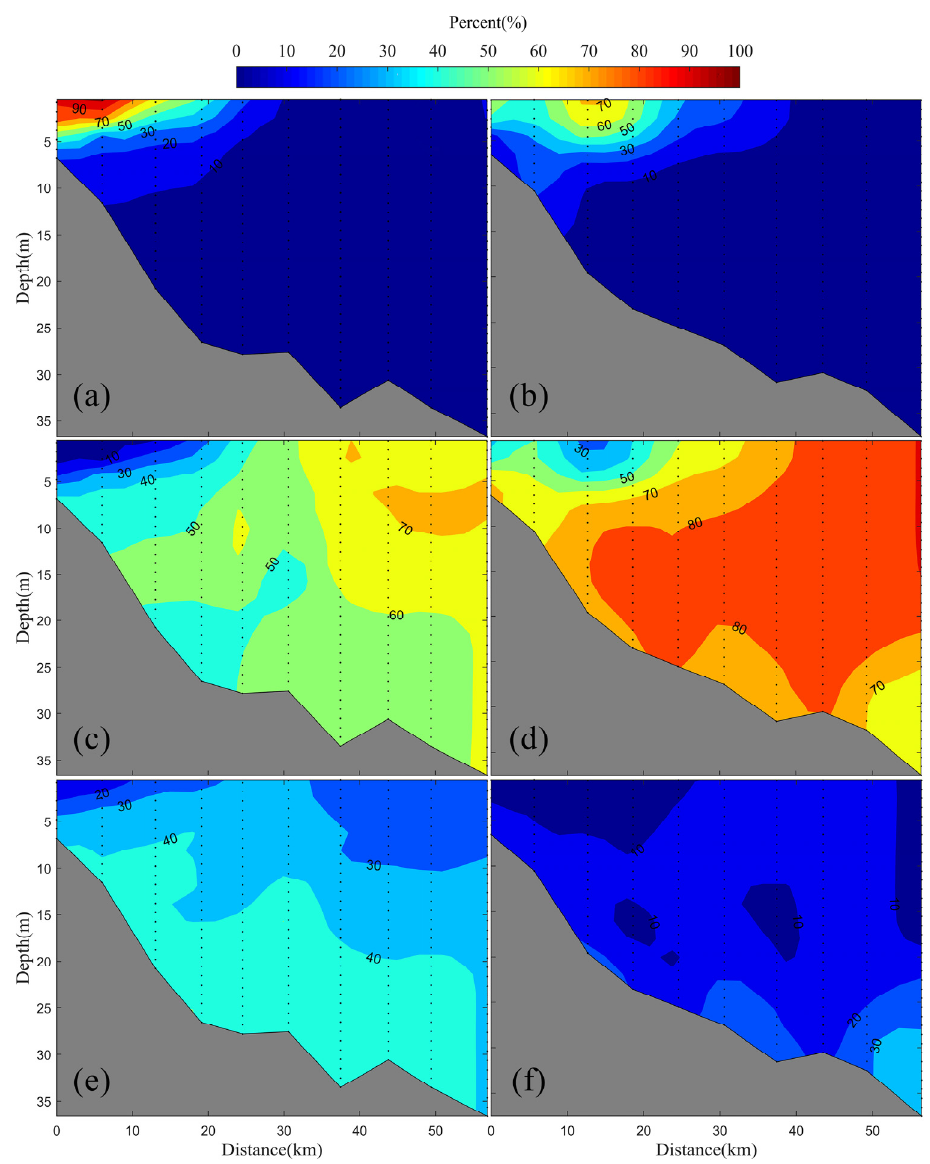
Figure 6. Vertical contributions (%) of PRDW ( a , b ), SCSSW ( c , d ) and SCSSUW ( e , f ) along the T1 section for the April ( a , c , e ) and May ( b , d , f ) cruises.